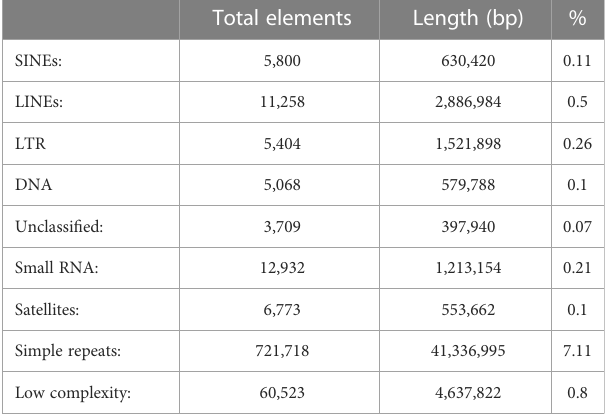
TABLE 3 Repeat content of the